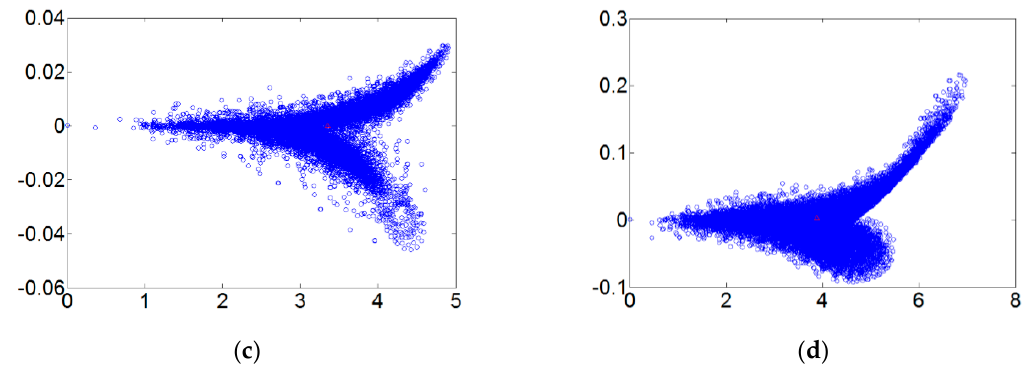
Figure 9. The order 0.3 fault dynamic error trace diagrams for all fault diameters. ( a ) Normal state; ( b ) fault diameter = 0.007; ( c ) fault diameter = 0.014; ( d ) fault diameter = 0.021.